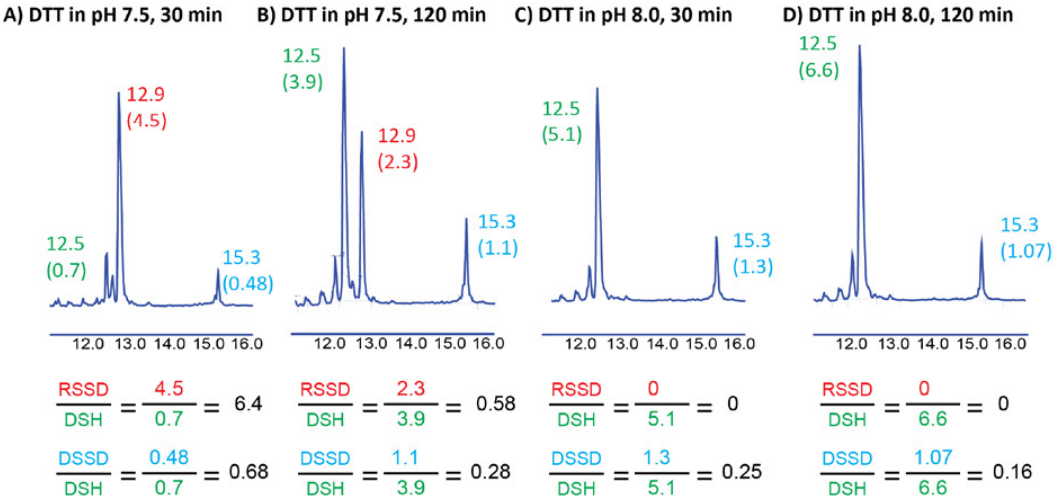
Fig. 4. The effect of incubation time with DTT in formation of the desired product or the side product. The numbers in parenthesis are peak area of each peak analyzed by One-manager unite of HPLC. The ratios RSSD/DSH and DSSD/DSH indicate incomplete reduction procedure and oxidation to dimer, respectively. The color codes of this figure are as indicated in Fig 3,